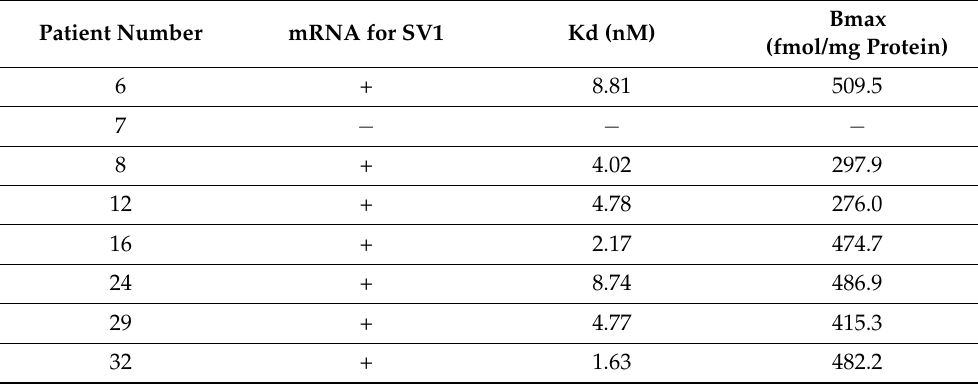
Table 3. Expression of mRNA for SV1 and binding characteristics of GHRH receptors in 11 human endometrial cancer